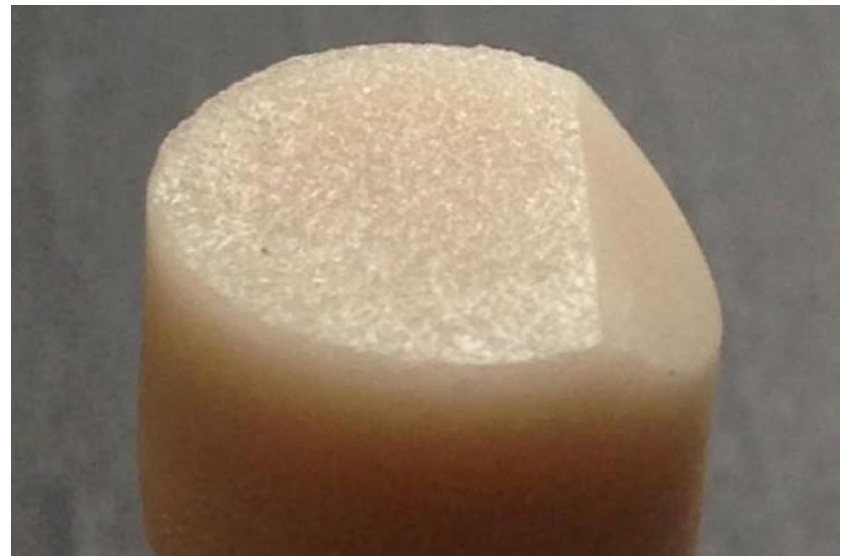
Figure 3. Beveled